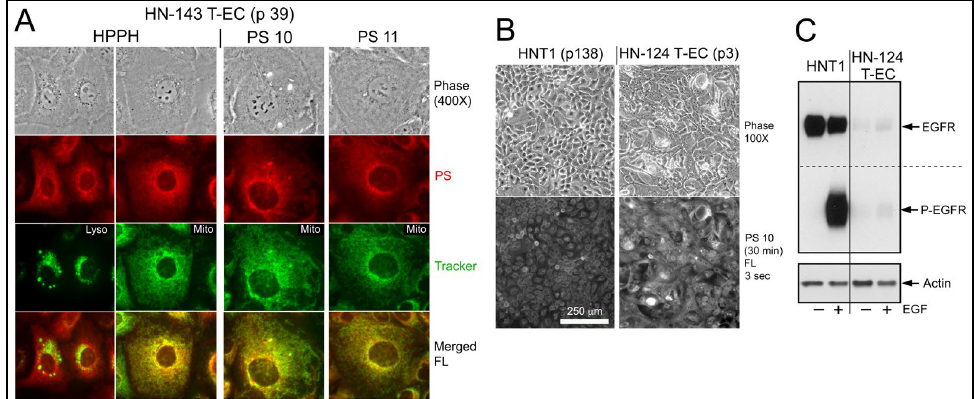
Figure 3. Subcellular location of HPPH, PS 10 and PS 11 and relationship of EGFR expression with uptake of PS 10. ( A ) Subcellular site of HPPH, PS 10 and PS 11 retention was determined in HN-143 T-EC cells after 24 h uptake (3 μM) and 24 h chase. Mitotracker served as marker for mitochondia. To demonstrate the distinct pattern of lysosomal compartment, HPPH-treated cells were also stained with lysotracker (left most panel). ( B ) Uptake of PS 10 (3 μM) by HNT1 cells and HN-124 T-EC (p 3) cultures. ( C ) Difference in the expression of EGFR protein and kinase activity (15 min treatment with EGF) by HNT1 and HN-124 T-EC.